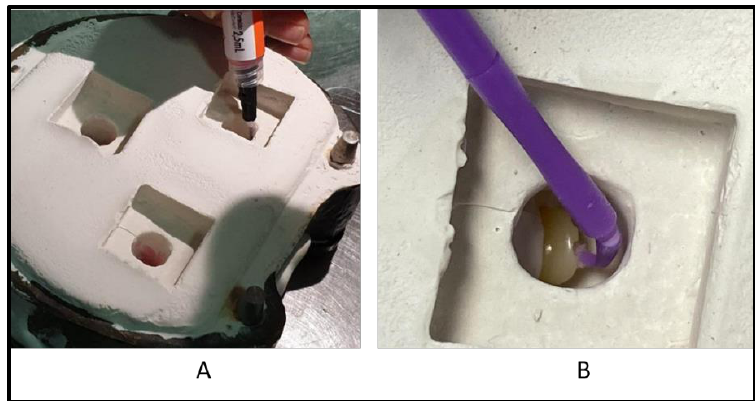
Figure 4. Chemical surface treatment of teeth with ( A ) hydrofluoric acid and ( B ) Silane coupling agent. The acrylized test samples were then thermocycled (6000 cycles, equivalent to 30 days) in distilled water between 5 to 55 °C (Model 1100, SD Mechatronik, Bayern, Ger- many) [19]. A universal mechanical testing machine (Model 4301, Instron, Canton, MA, USA) was used for applying a point compressive load at 45 degrees from the long axis of crosshead speed of 5.0 mm/min, temperature 18.00 ± 1 °C, and humidity 50 ± 1%. The size